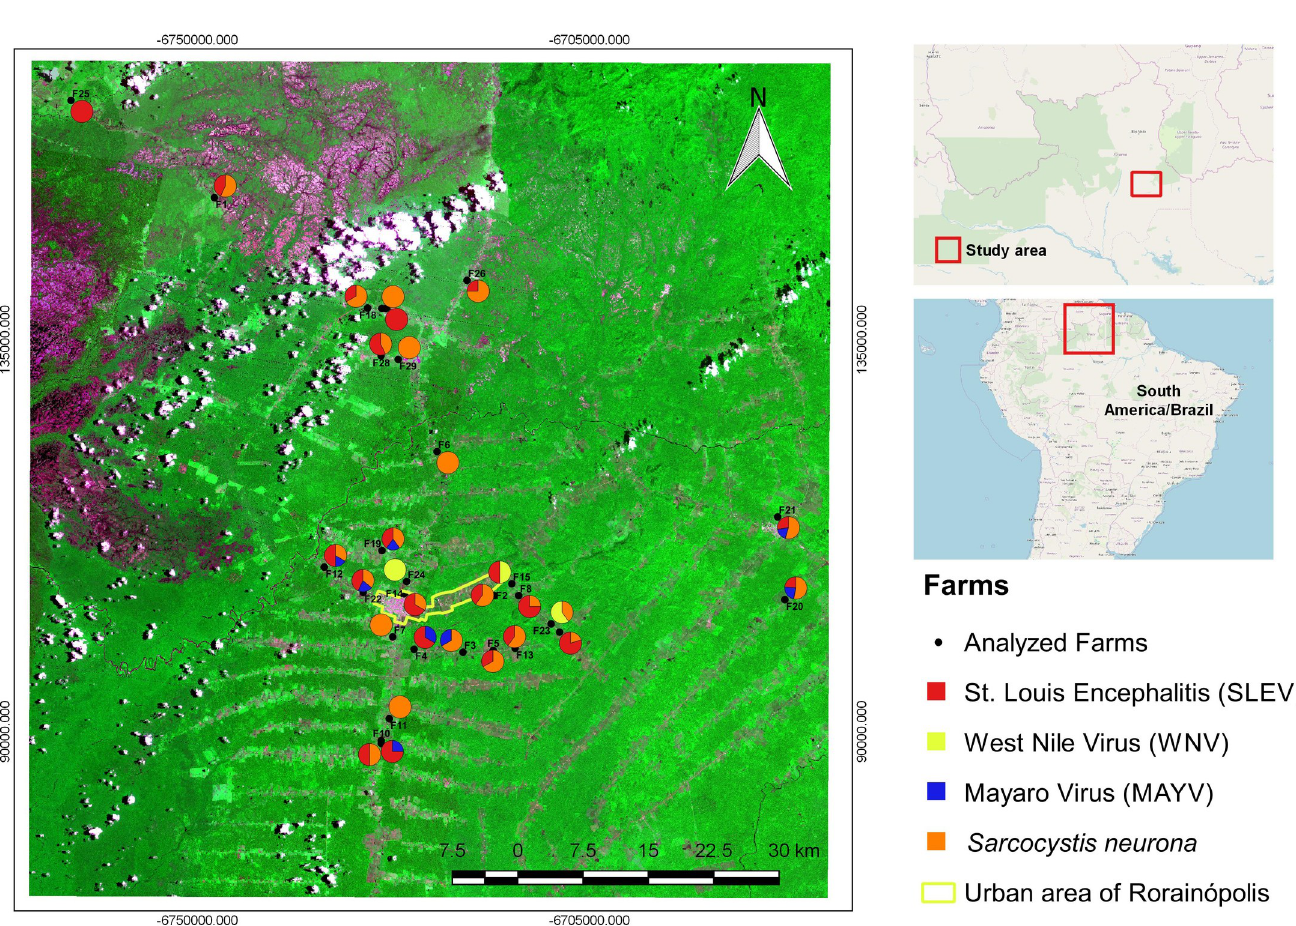
Fig 1. Geographic distribution of the infected horses with viruses and protozoans derived from properties with an epidemiological link or in which cases and/ or the death of horses with neurologic disorders occurred. The farms with positive results by plaque reduction neutralization tests (PRNt) for viruses and the indirect immunofluorescence antibody test (IFAT) for S . neurona in the municipalities of Roraino´polis, Caracaraı´and S ã o Luiz, Roraima state, Brazilian Amazon, are shown. The coloured circles represent the proportion of positive results per infectious agents Saint Louis Encephalitis Virus (SLEV), West Nile Virus (WNV), Mayaro virus (MAYV), Sarcocystis neurona ( S . neurona